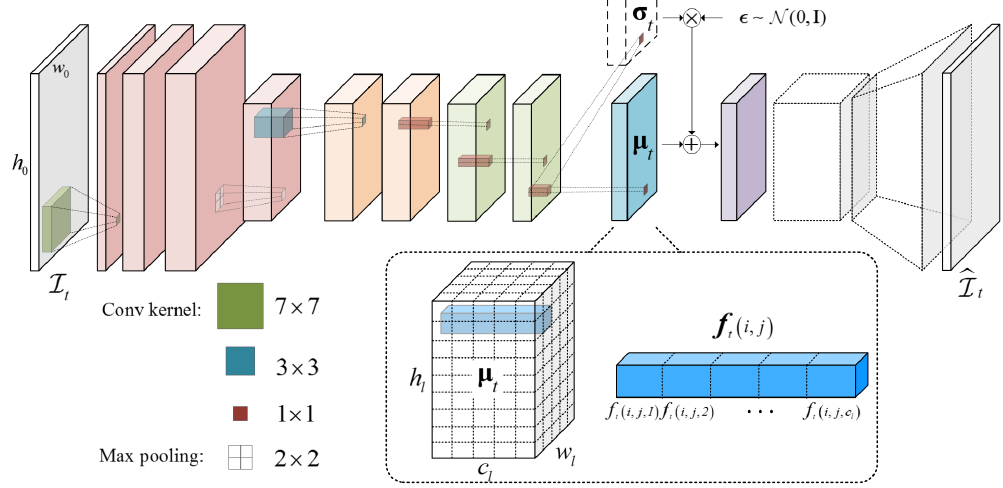
Figure 2. The network architecture of the proposed convolution-based VAE. Three blocks with different convolution kernels marked green, blue, and red constitute the encoder. The mean map µ the encoder is defined as the feature matrix that consists of the feature vector f